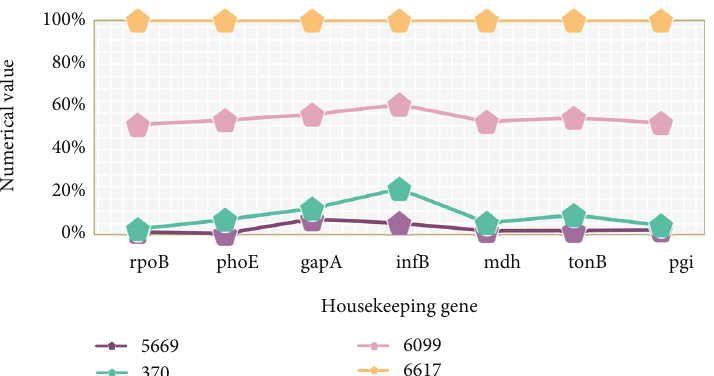
Figure 2: Homology of strains.